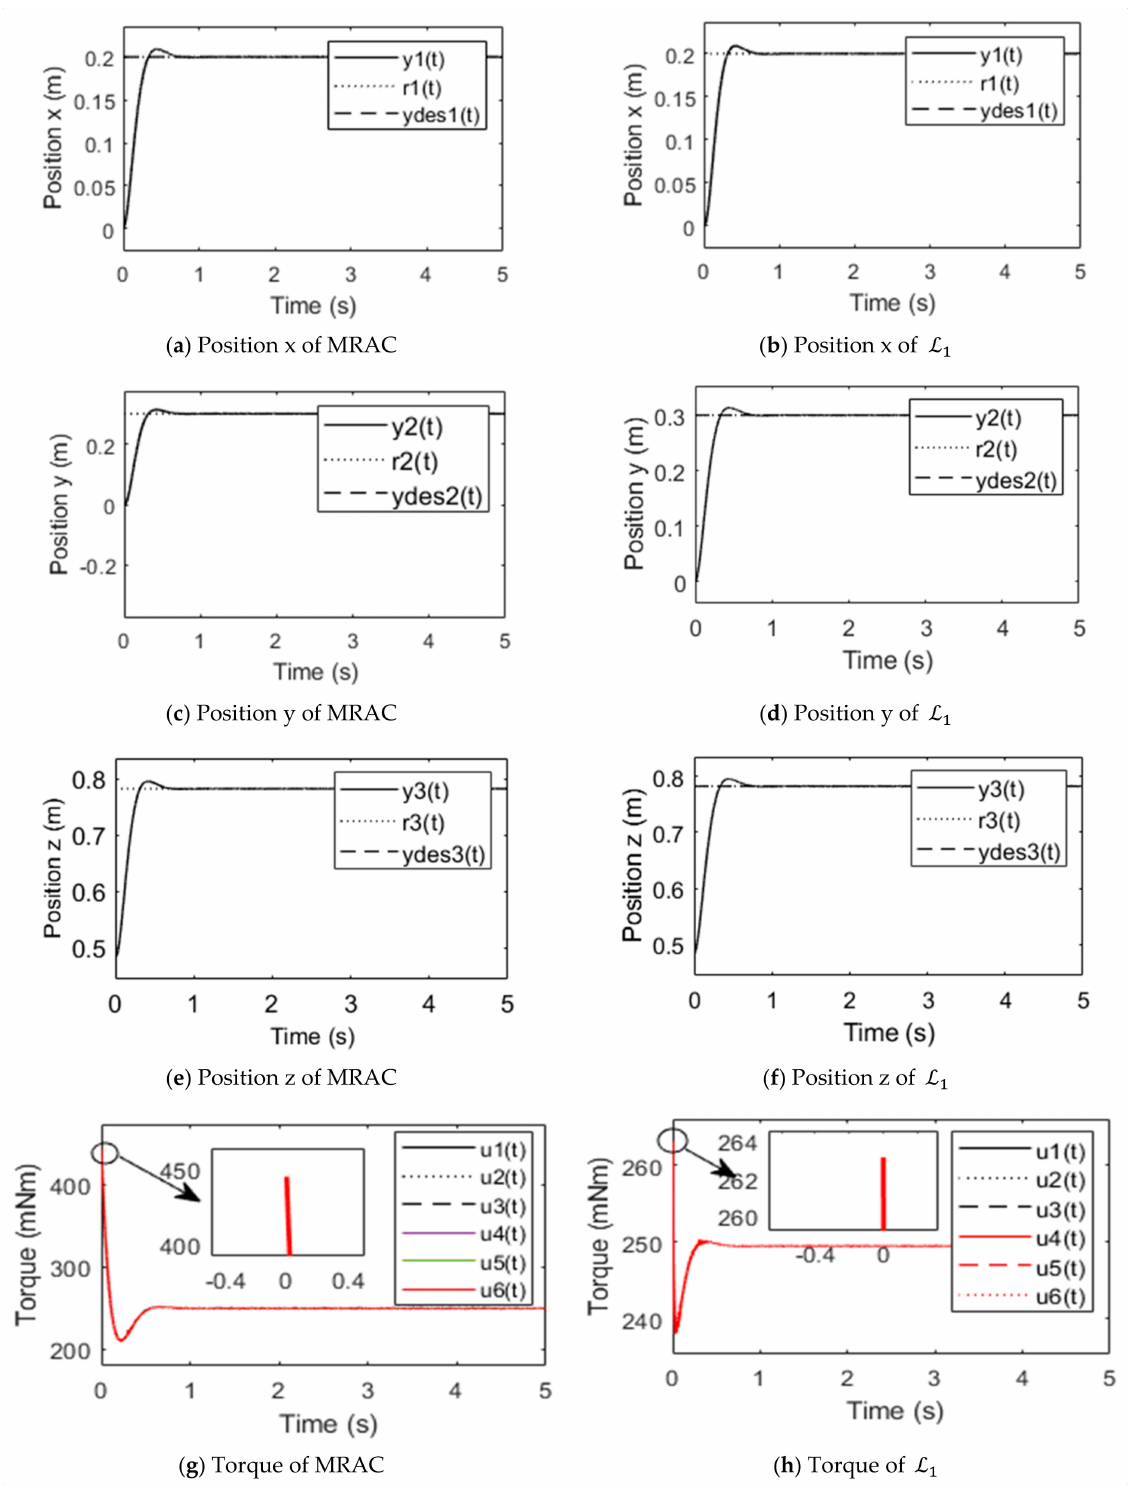
Figure 7. Performance of MRAC and L 1 adaptive controller for r = [ 0.2 0.3 0.78 0.25 0.5 1.0 ] . ( a ) X-position curve of the platform when using MRAC controller; ( b ) X-position curve of the platform when using L 1 adaptive controller; ( c ) Y-position curve of the platform when using MRAC controller; ( d ) Y-position curve of the platform when using L 1 adaptive controller; ( e ) Z-position curve of the platform when using MRAC controller; ( f ) Z-position curve of the platform when using L 1 adaptive controller; ( g ) Torque u curve of the platform when using MRAC controller; ( h ) Torque u curve of the platform when using L 1 adaptive